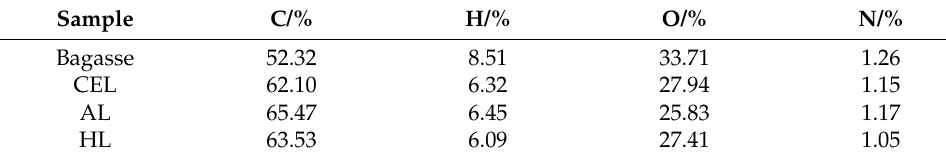
Table 2. Elemental composition of alkaline and hydrothermal